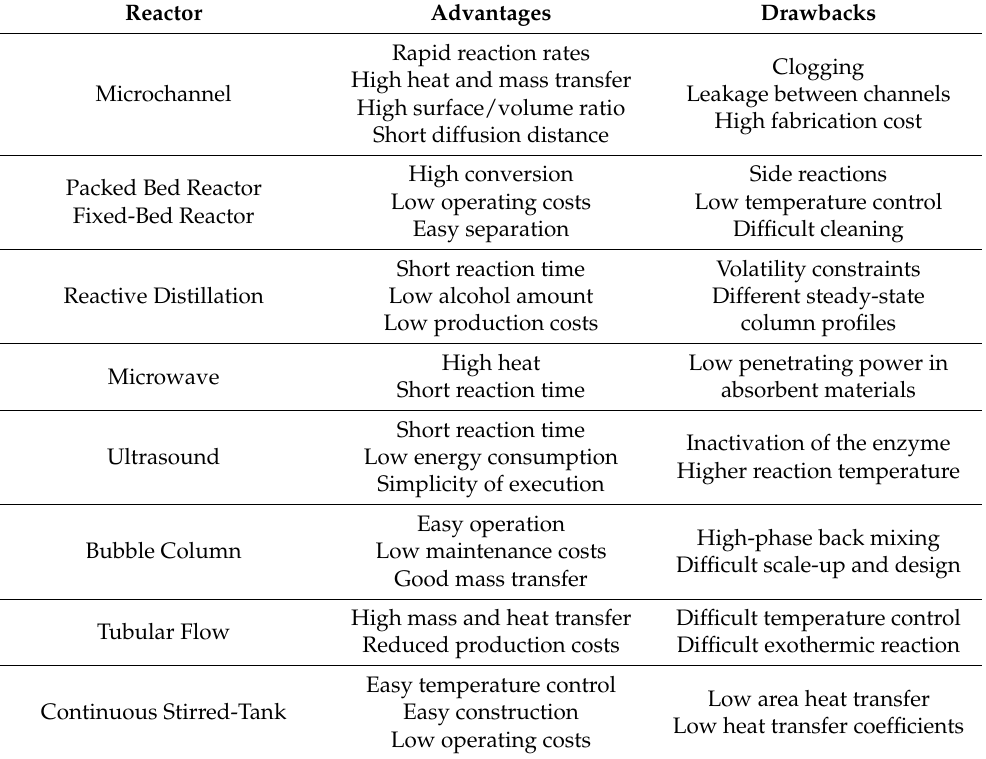
Table 1. Summary of reactors